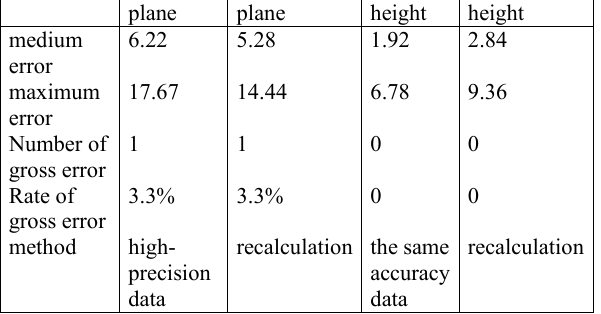
Table 6. Statistical results of field 2